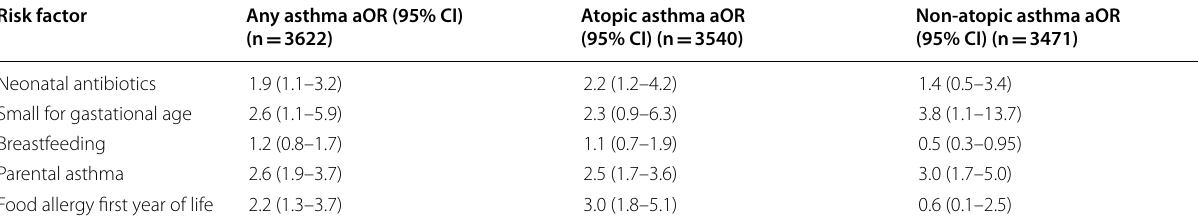
Table 1 Adjusted odds ratios to be diagnosed with any asthma, atopic asthma, and non‑atopic asthma at 12 years